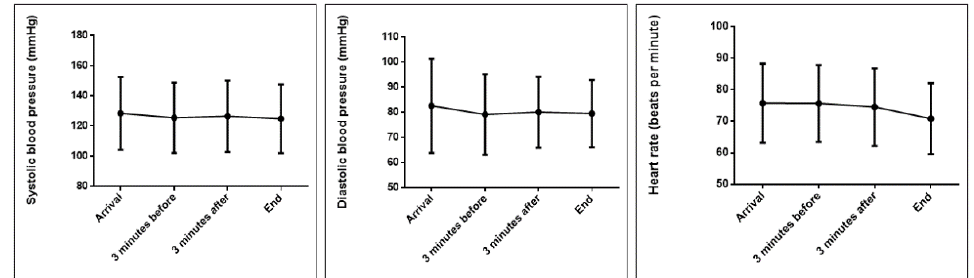
Figure 1. Evolution of physiological parameters in patients as a whole.